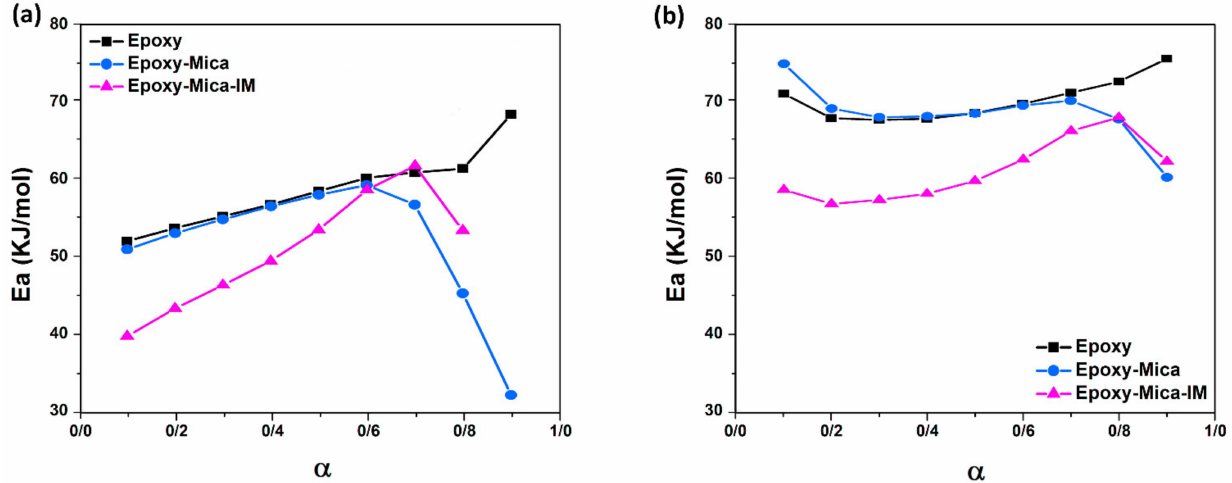
Figure 9. Change in E α in terms of conversion based on Friedman model ( a ) and KAS model ( b ), for the blank epoxy and its